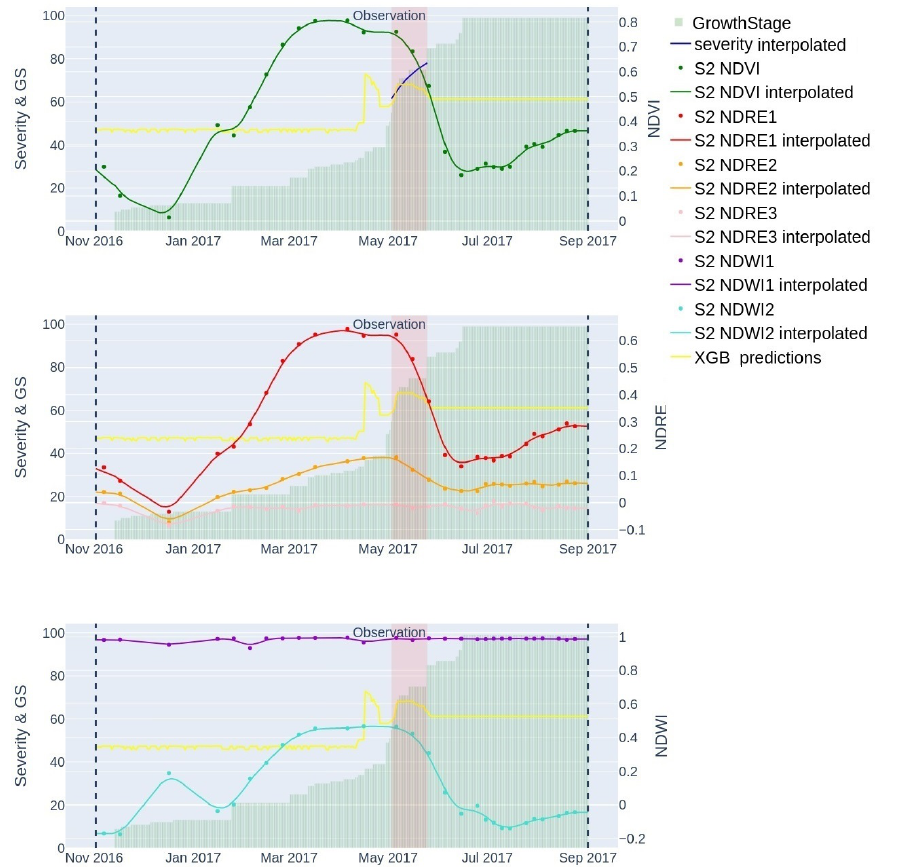
Figure 9. Time series plots of different remote-sensing indices: NDVI (S2 NDVI), NDWI (S2 NDWI1, S2 NDWI2) and NDRE (S2 NDRE1, S2 NDRE2, S2 NDRE3) calculated using the Sentinel-2 images along with the interpolated values on a sample